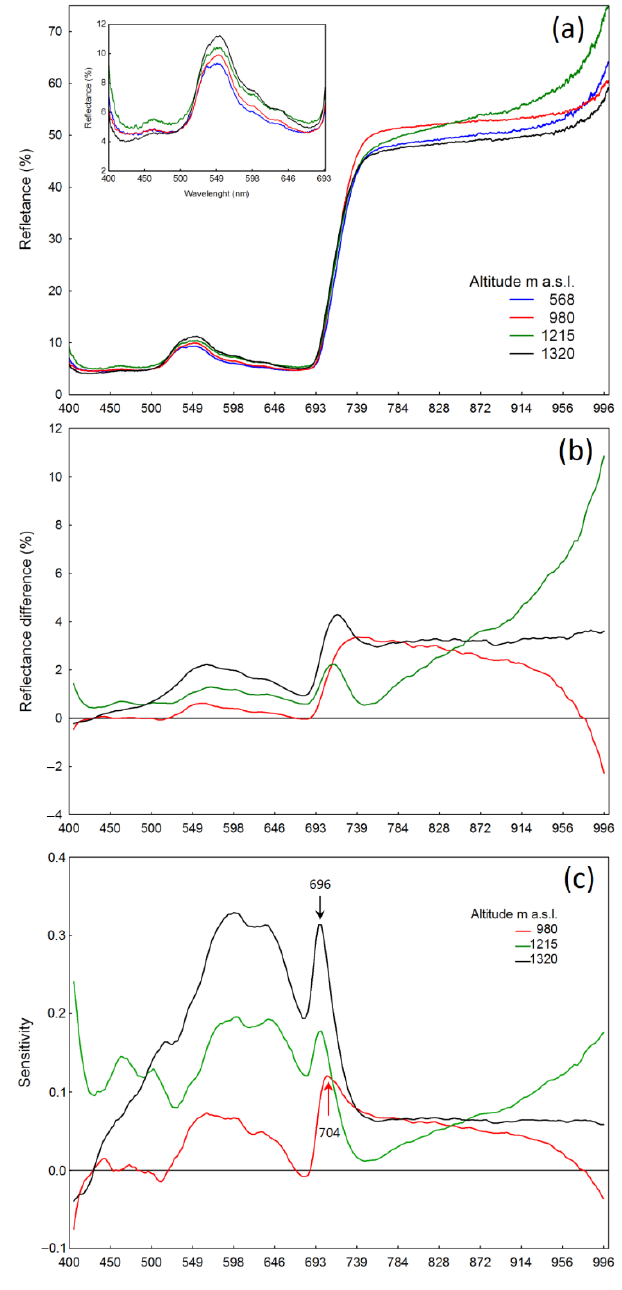
Figure 4. Reflectance curves for leaves of green alder ( A. viridis ) plants growing in the Bieszczady Mts. at different elevations: 568, 980, 1215, and 1320 m a.s.l. ( a ) reflectance—inset is an enlarged graph of PAR reflection; ( b ) reflectance difference—calculated by subtracting reflectance intensity values (%) for plants growing 568 m a.s.l. from reflectance intensity values for plants growing 980, 1215, or 1320 m a.s.l., respectively (see Material and methods); ( c ) sensitivity—calculated by dividing the RD values by mean reflectance values (%) for plants growing at 568 m a.s.l., N = 40.